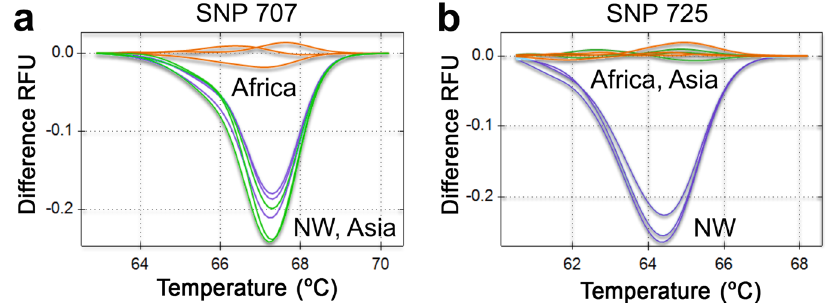
Fig. 3 High-Resolution Melting (HRM) analysis of Pfs47 SNPs 707 and 725. HRM pro fi le in P. falciparum DNA samples from Africa (GB4, orange), Asia (Thai 17, green), and New World (7G8, blue) at three DNA concentrations (2, 0.2, 0.02 ng/ μ l). a HRM difference curves for Pfs47 SNP 707. b HRM difference curves for Pfs47 SNP 725.